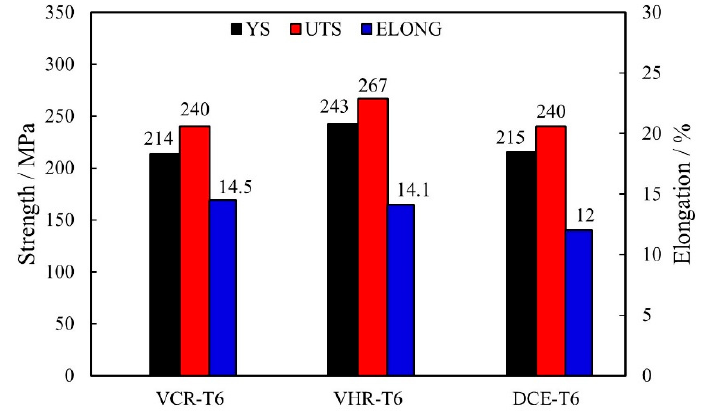
Figure 14. Comparison of tensile properties.